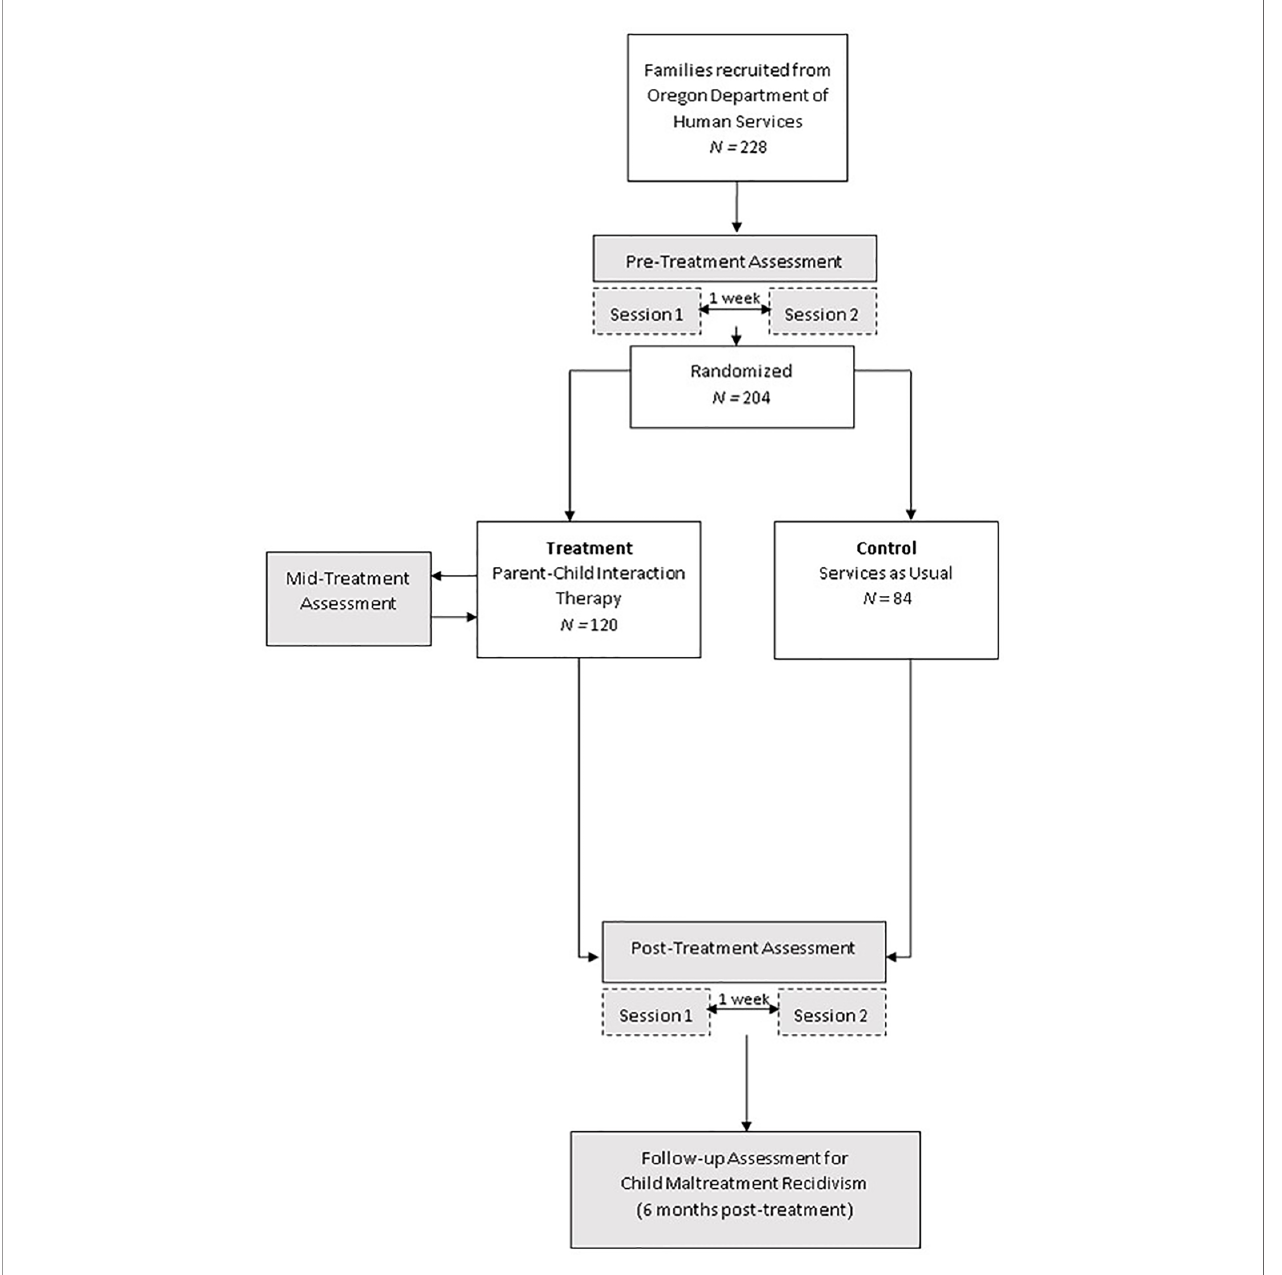
FIGURE 2 | Coaching Alternative Parenting Strategies (CAPS) Study